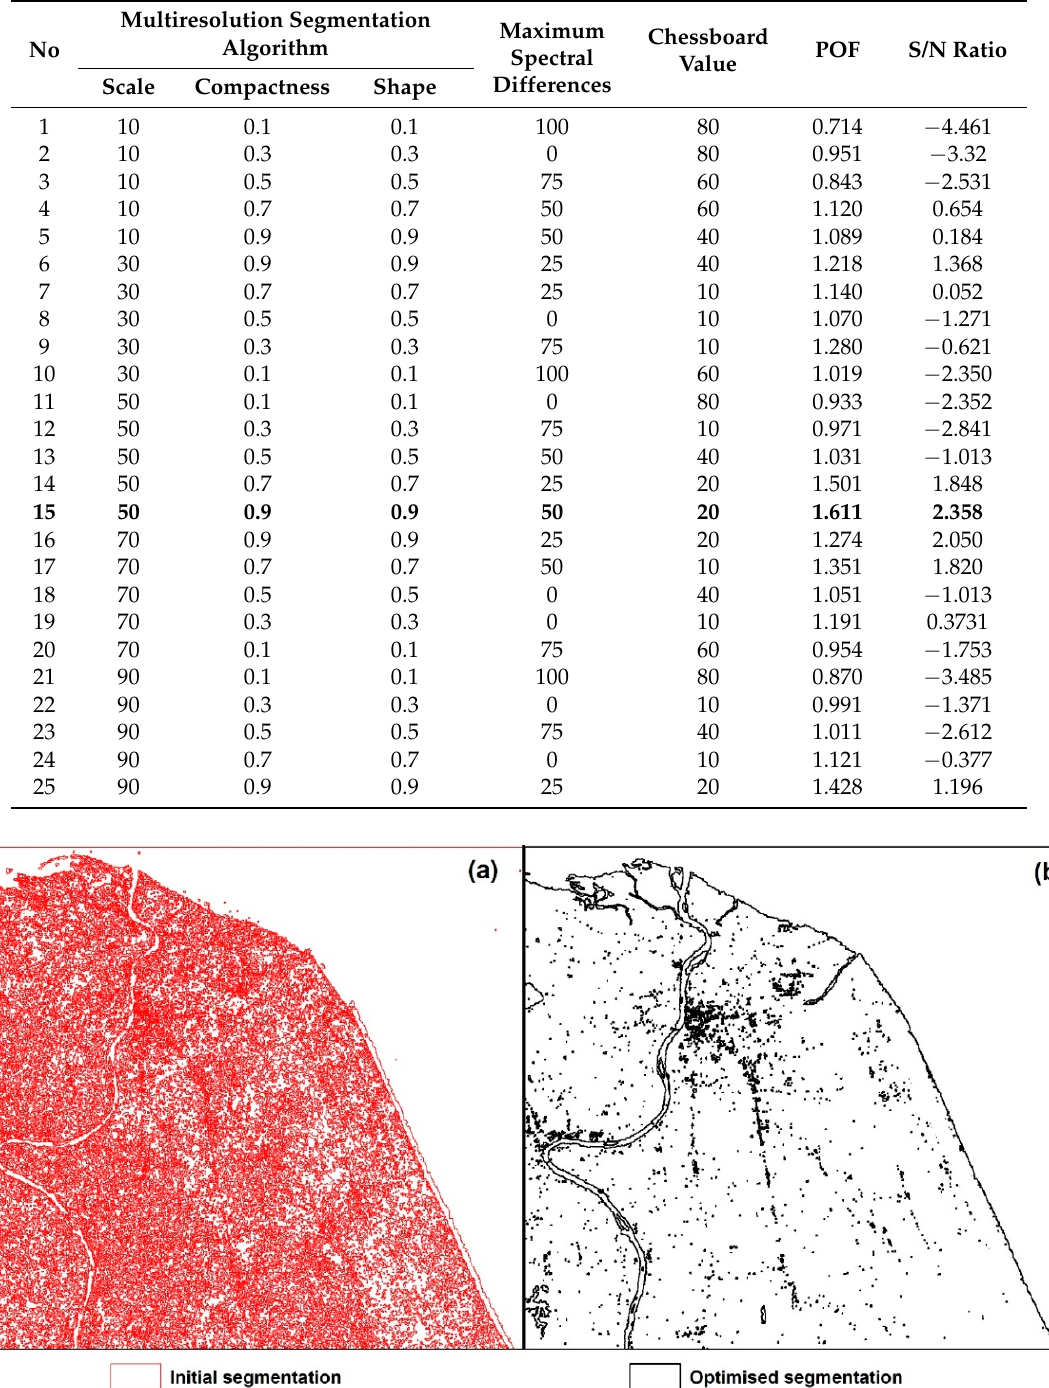
Table 5. L25 Taguchi orthogonal array on segmentation variables.